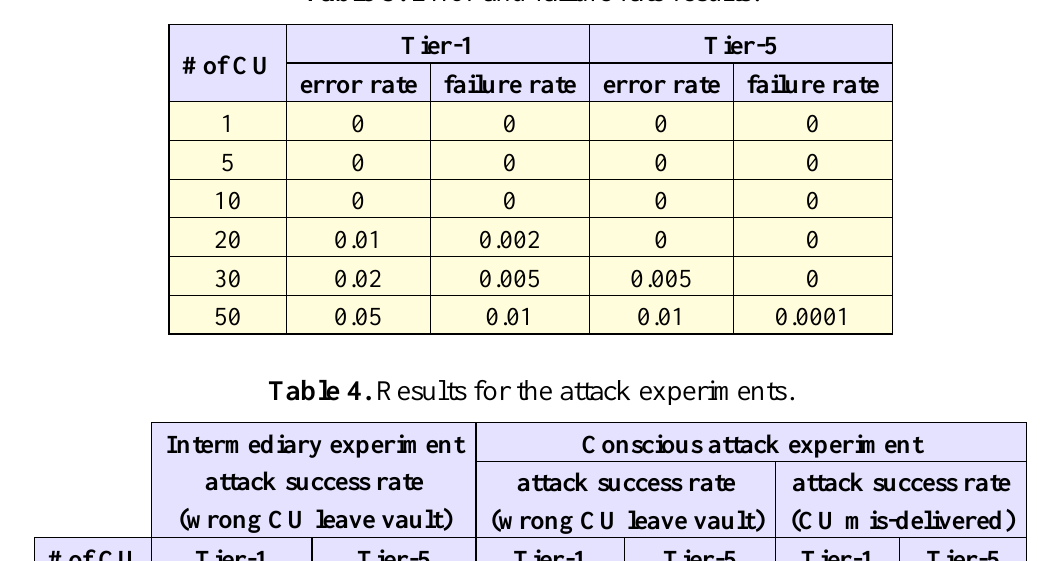
Table 3. Error and failure rate results.